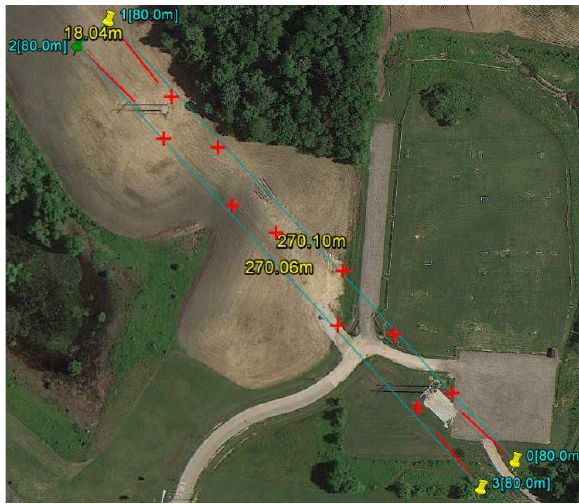
Figure 6. Flying plan of two strips and GCP locations